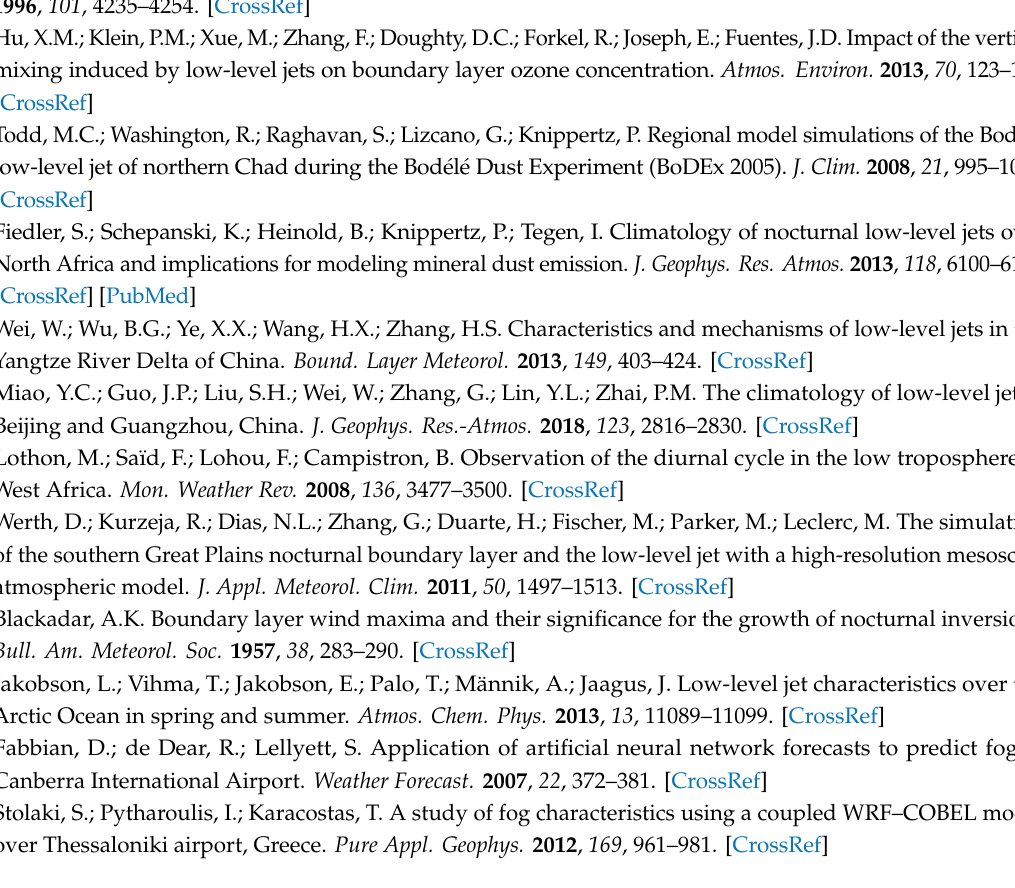
Figure S1: Synoptic charts at 850 hPa from Korea Meteorological Administration at 0000 UTC 12 May, 2016. Figure S2: Wind directions of LLJs in (a) spring, (b) summer, (c) autumn, and (d) winter in 2016. Figure S3: Vertical velocity from 15 to 23 December, 2016 (Figure 7 in Han et al. [44]). Figure S4: Profile of temperature from 0000 LST 16 December to 2300 LST 23 December. Figure S5: Vertical profiles of PM 2.5 mass concentration observed with Tethered balloon (Figure 9 in Han et al. [44]). Figure S6: Vertical profile of wind speed from 0000 UTC to 2300 UTC